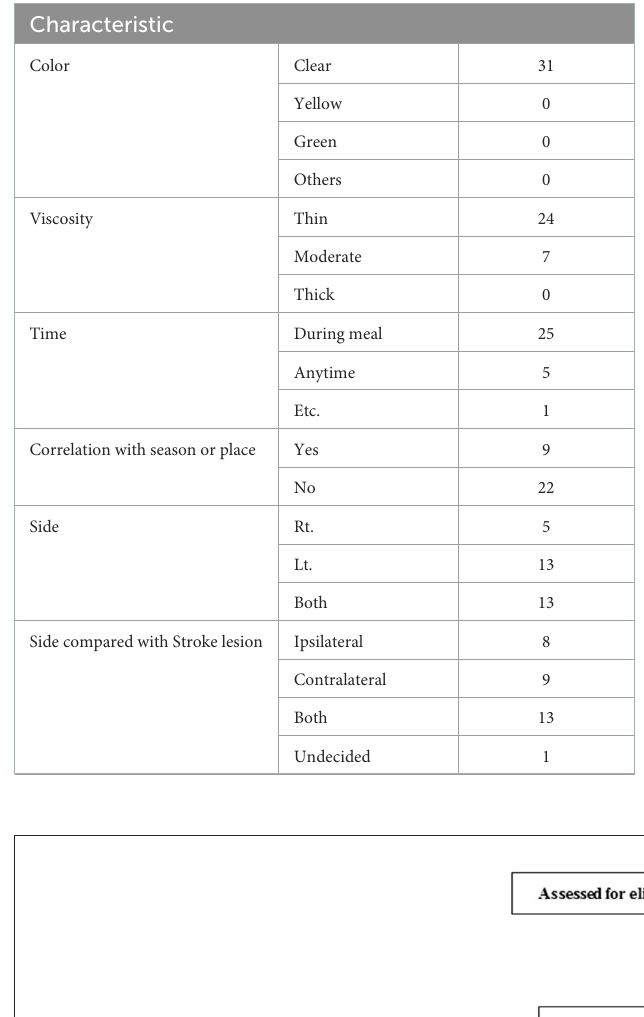
TABLE 1 Clinical characteristics of rhinorrhea in the chronic rhinitis group.